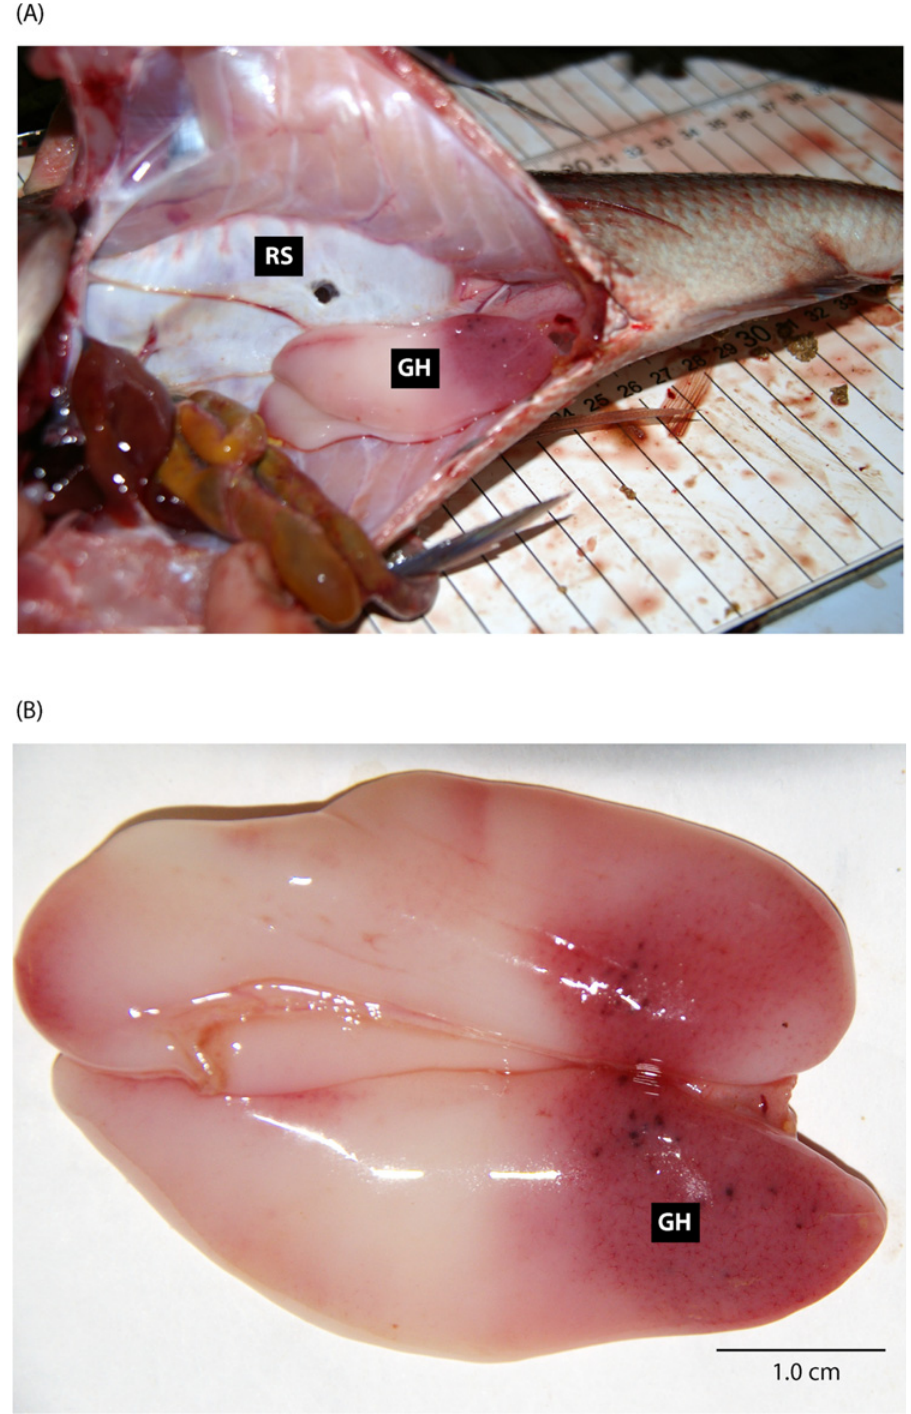
Fig 1. Internal view of the (A) coelomic cavity and (B) gonad of a male Chrysophrys auratus (38.5 cm TL) that was angled from 32.5 m and had a ruptured swim bladder (RS — 1.3 cm) and posterior gonad haemorrhaging (GH). The location of the gonad haemorrhage was typical across all fish with this clinical sign. This fish also had a prolapsed cloaca, organ displacement and liver, kidney and coelomic cavity